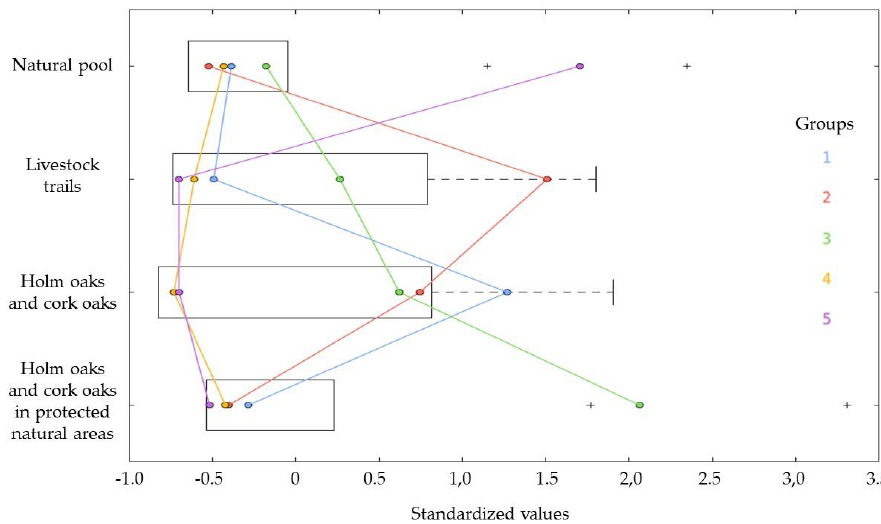
Figure 6. Parallel box plot.